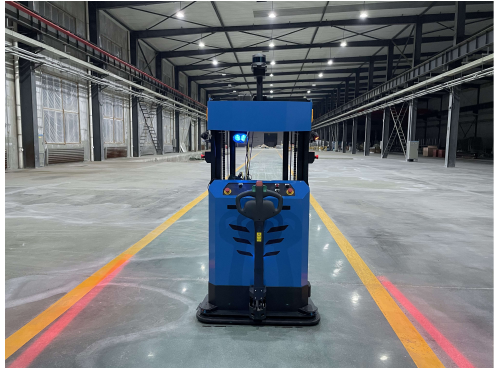
Figure 1. Automated unmanned